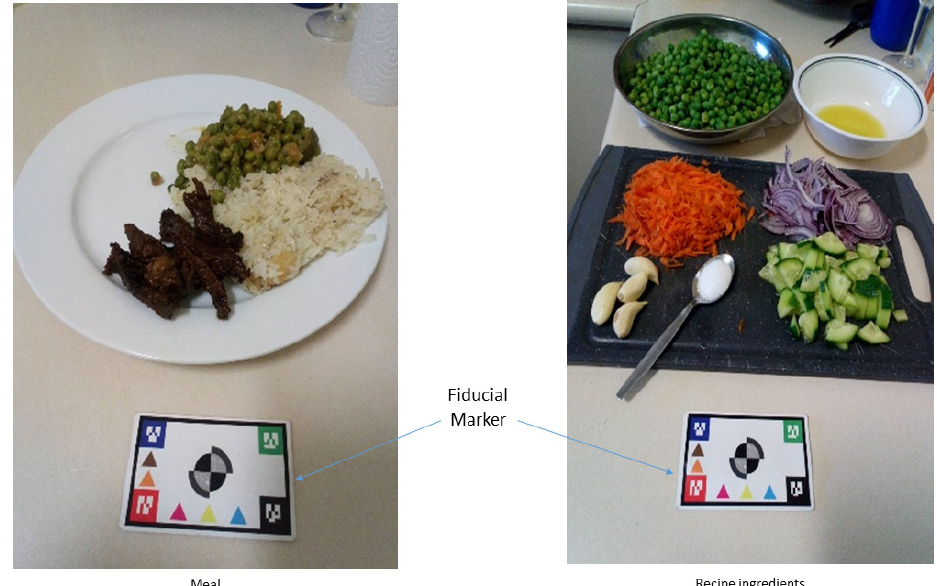
Figure 2. Example image illustrating the collection of food items and ingredients with a fiducial marker. Table 1. Data collection framework for the nutritionists’ study.